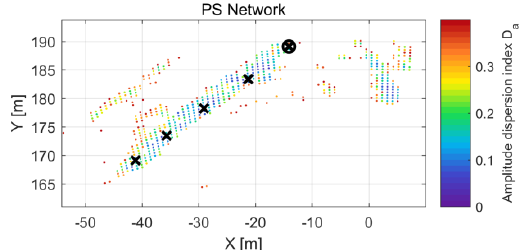
Figure 2. Result of selected PS points.